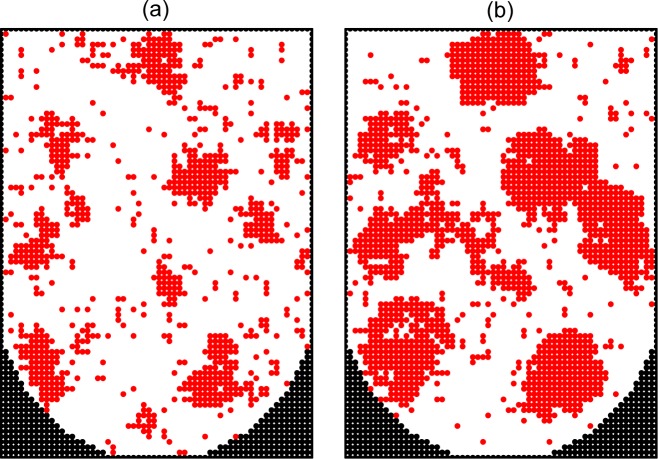
Monte Carlo simulation of cell proliferation and spheroid formation in the microwells.Cross sections of a microwell along the main axis at ϑ = 0.2 (a) and 0.4 (b) with relatively rapid cell diffusion (pdiv = 10−4) and no cell-surface adhesion (ϵcs = 0).